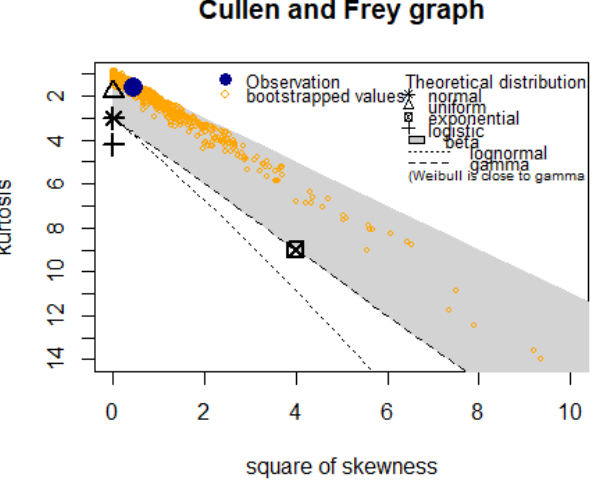
Figure 6. Estimated marginal distribution for HIV/AIDS for males.